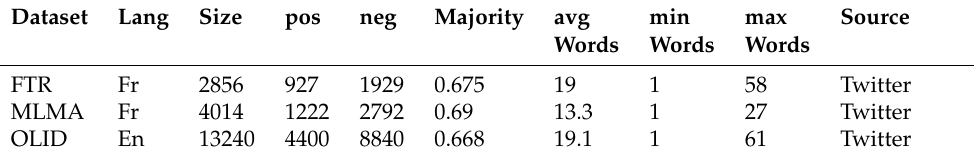
Table 4. Dataset